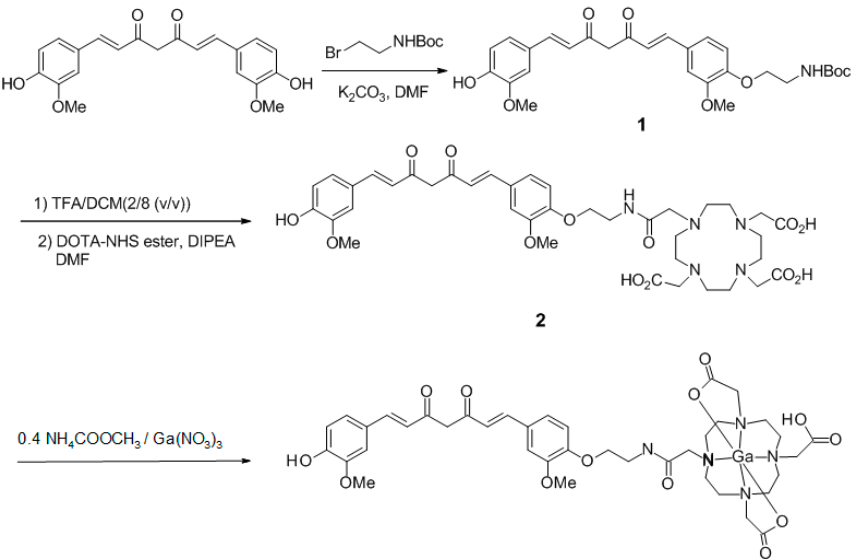
Figure 1. Synthetic pathway for the preparation of DOTA-C21 and its complexation with Ga(III) by reacting DOTA-C21 with Ga(NO 3 ) 3 at 1.5:1 metal-to-ligand molar ratio in 0.4 M ammonium acetate solution for 30 min at 95 °C.